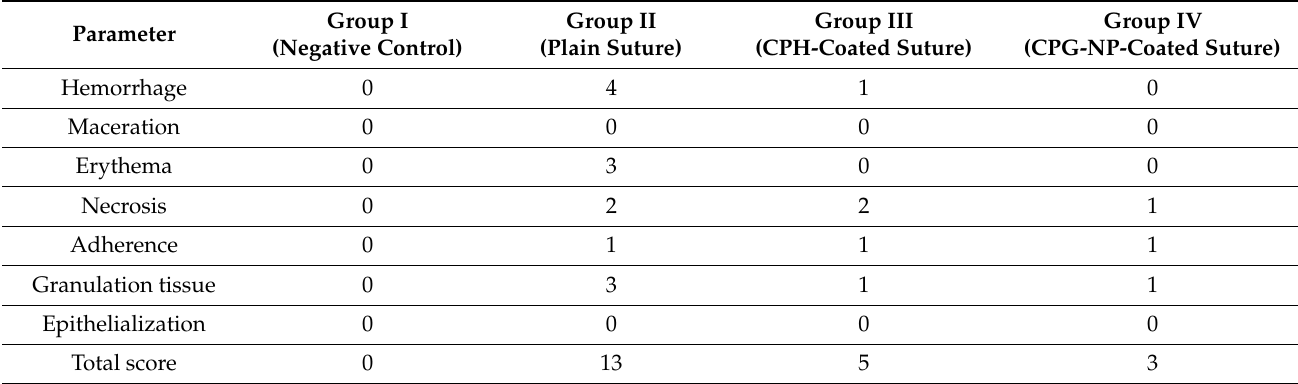
Table 5. Histopathology scoring studies for all treatment groups ( n = 8).